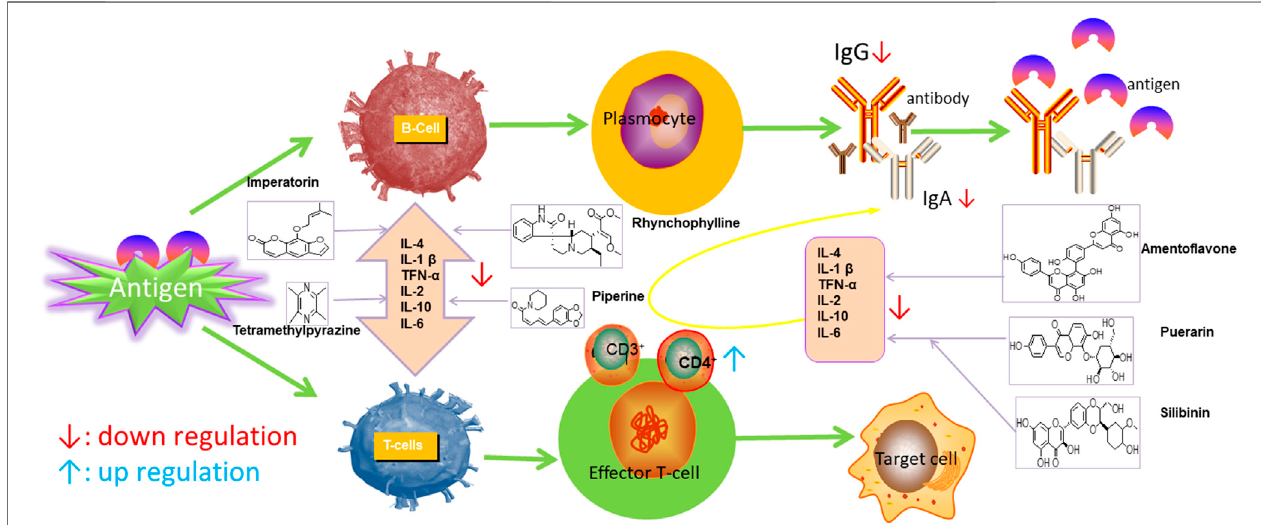
FIGURE 2 | Effects of natural drugs on immune system. Interleukin 1 β (IL-1 β ), interleukin 6 (IL-6), tumor necrosis factor- α (TNF- α ).